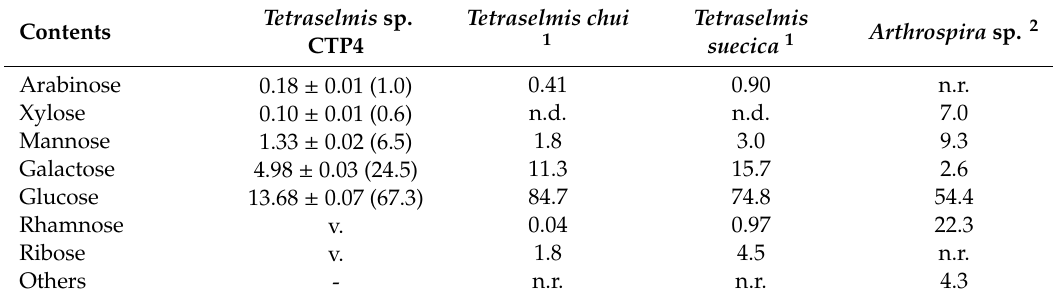
Table 3. Sugar composition of Tetraselmis sp. CTP4 grown semi-continuously in industrial tubular photobioreactors (g / 100 g). Values represent the mean and corresponding standard deviation ( n = 3). Values in brackets represent the mol% of total sugars. Values from the literature for Tetraselmis chui , Tetraselmis suecica , and Arthrospira sp. are also presented in % of total sugars. v.—vestigial ( < 0.1 g / 100g); n.d.—not detected; n.r.—not